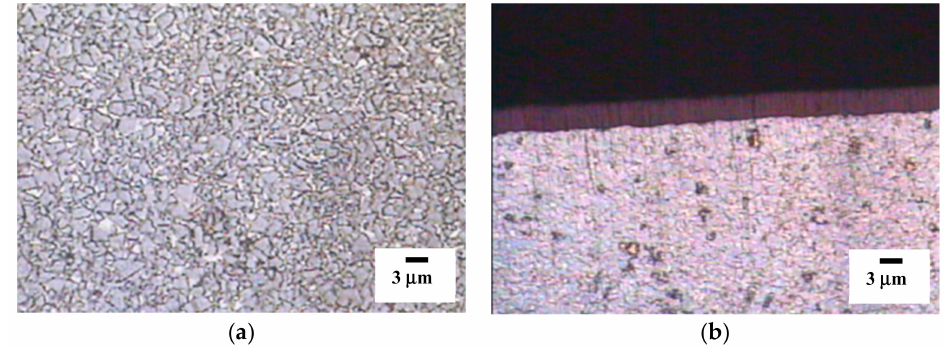
Figure 1. ( a ) Top view of the WC PH7930 micro-grain sintered microstructure (1500 × ); ( b ) AlTiN coating + substrate microstructure in cross-section view (1500 × ) (Courtesy of Palbit).